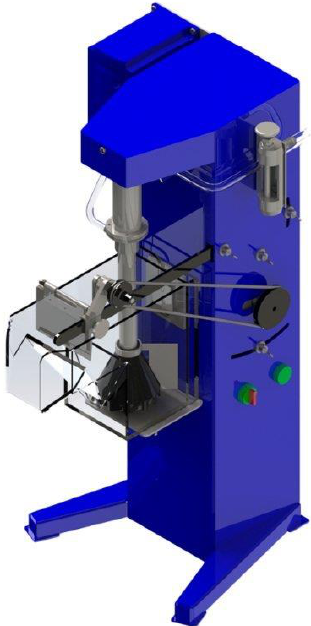
Figure 1. Flotation machine 137 В -FL.